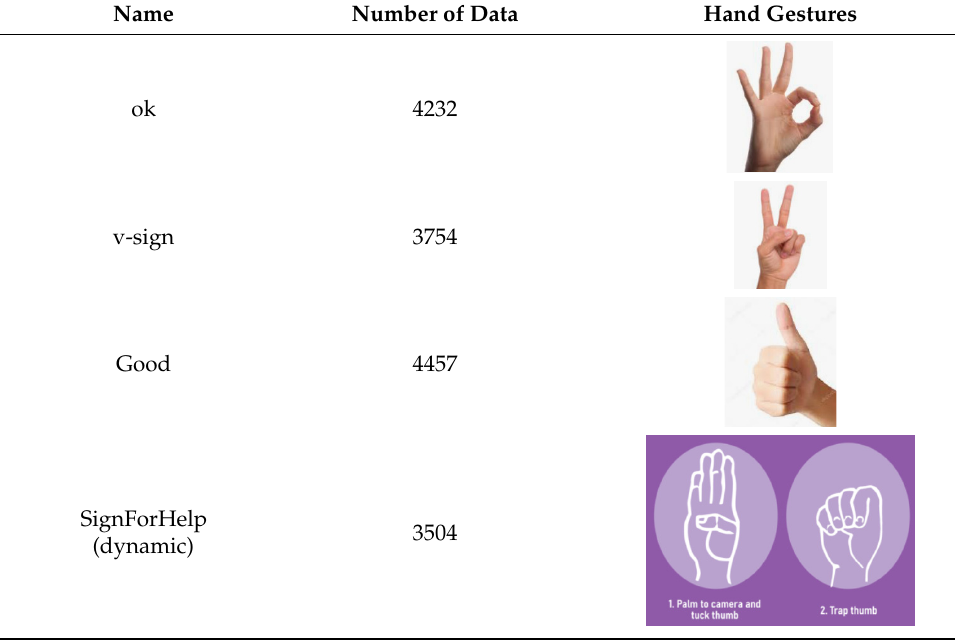
Table 4. Emergency rescue recognition dataset.